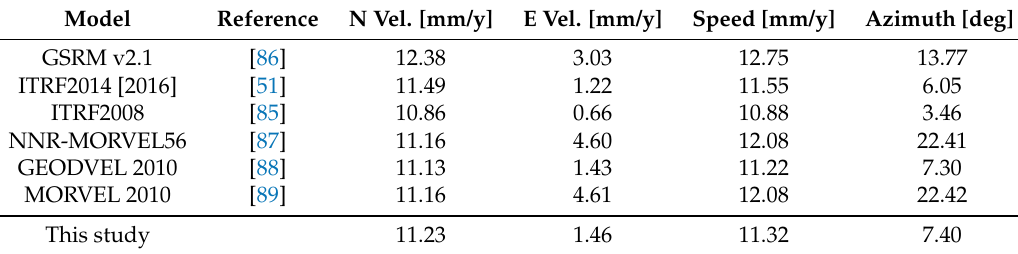
Table 7. Tectonic plate motion at Aboa site using various plate motion models in the NNR* frame of the Antarctic plate. The velocity and speed are given in mm/y. Azimuth is measured clockwise from the North and expressed in degrees.